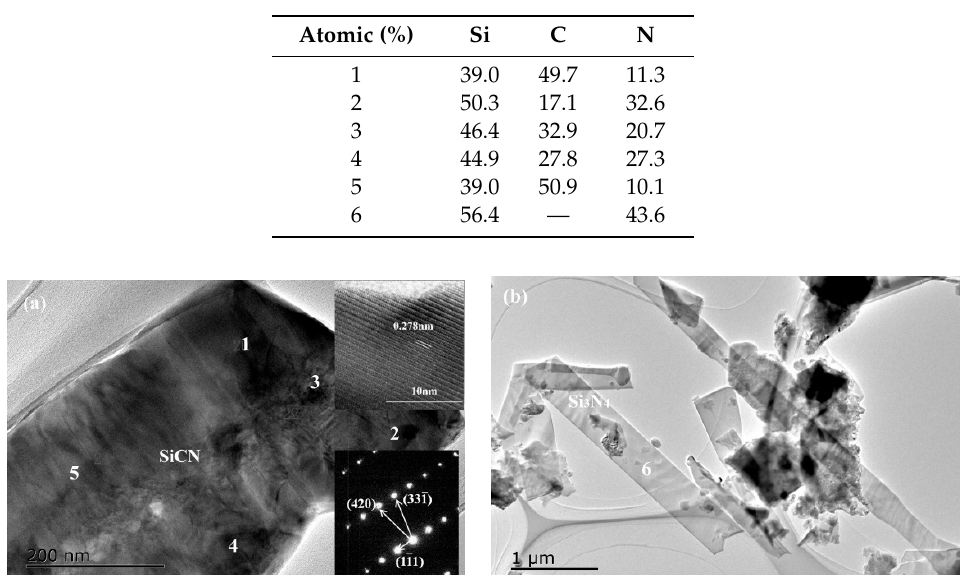
Table 5. EDS analysis results of samples (at %).